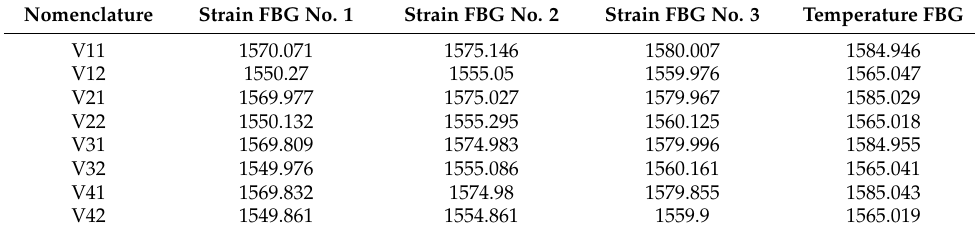
Table 2. Beam sensor wavelengths